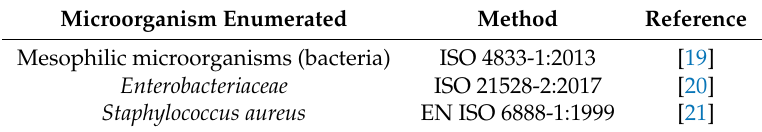
Table 3. Determination of microbial counts in raw milk and udder surface samples.